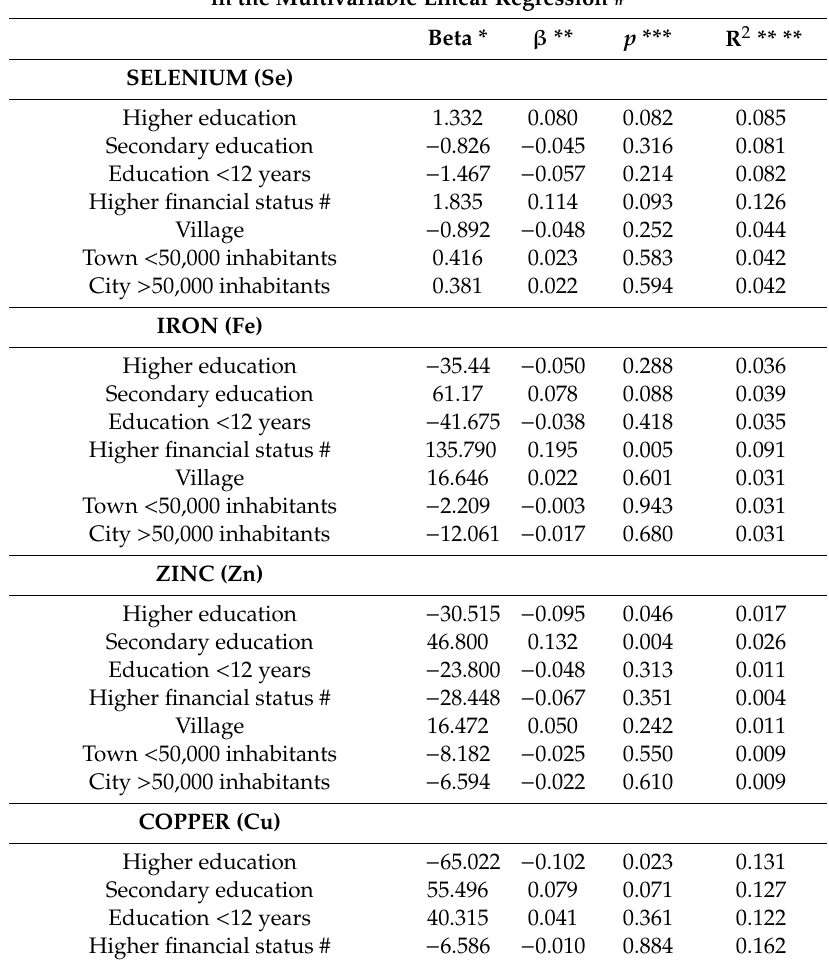
Table 4. The adjusted relationships between sociodemographic indicators and microelement